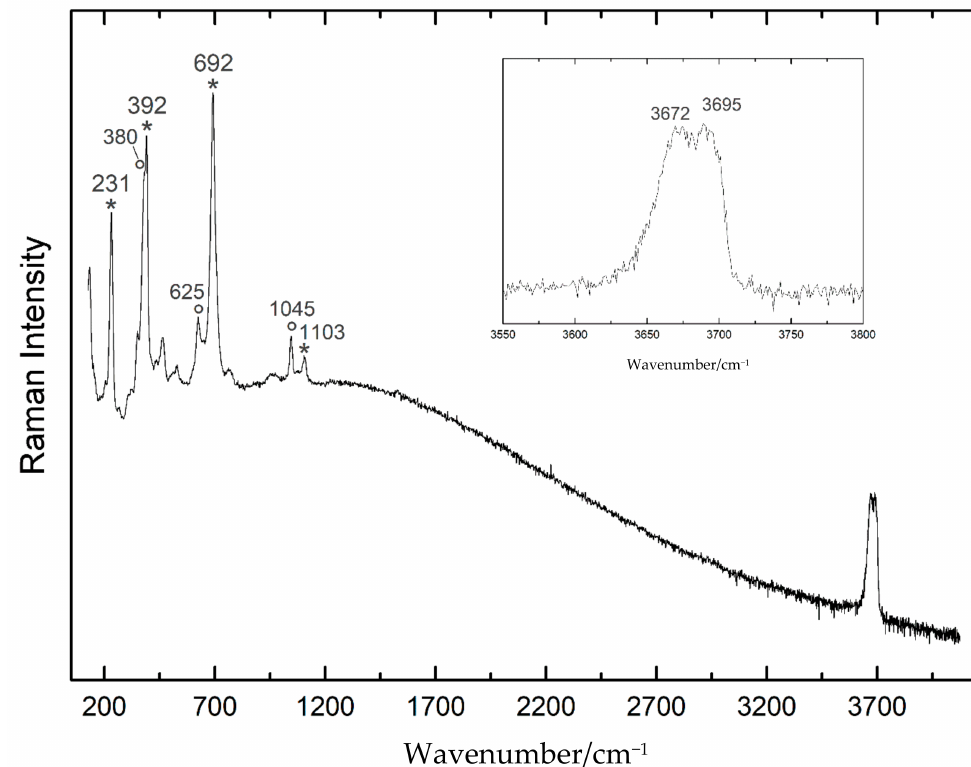
Figure 5. Raman spectra of a bundle consisting of chrysotile (circle assignment) and fibrous antigorite (asterisk assignment) collected with portable Raman. The contribution of OH-stretching of the two phases occurred simultaneously. A comparison with Raman spectra collected with HRS is reported in Supplementary Material